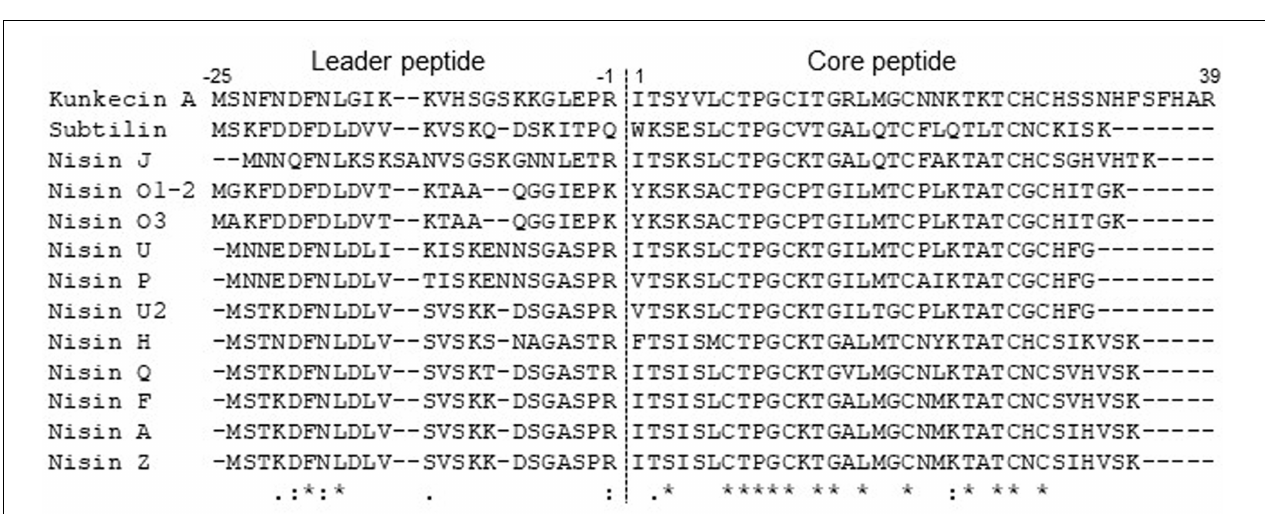
FIGURE 2 | Comparison of biosynthetic gene clusters of kunkecin A and nisin A. The putative kunkecin A biosynthetic genes are labeled with the same pattern as each corresponding gene in the nisin A biosynthetic cluster. No genes corresponding to nisI , nisR , or nisK (filled with black) were found in the kunkecin biosynthetic gene cluster.